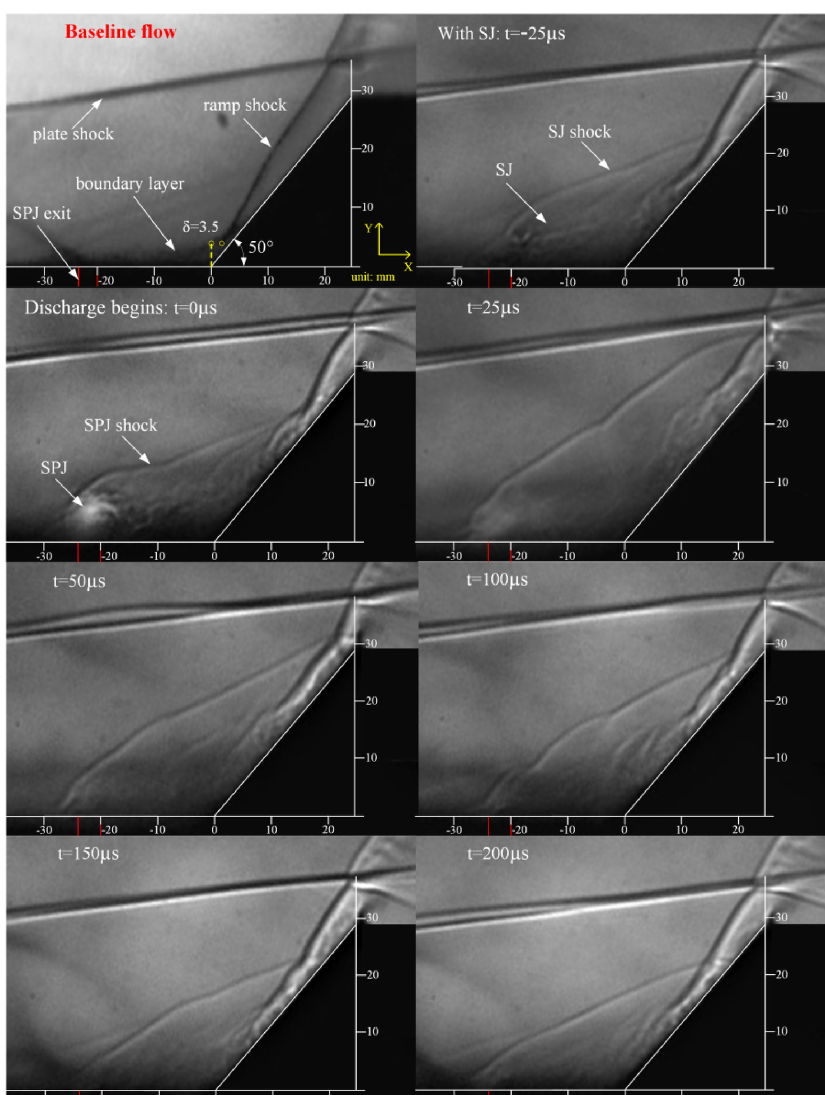
Figure 40. Variation of jet front velocity by time. [69]. Figure 36. Variation of jet front velocity by time.